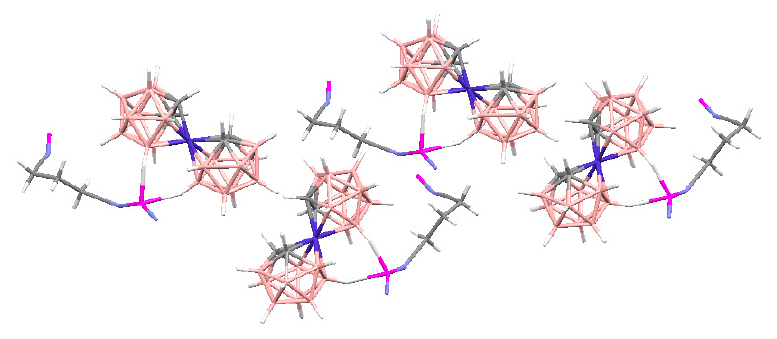
Figure 103. X-ray structure of {((NC(CH 2 ) 3 CN)Ag)[3,3’-Co(1,2-C 2 B 9 H 11 ) 2 ]} n .